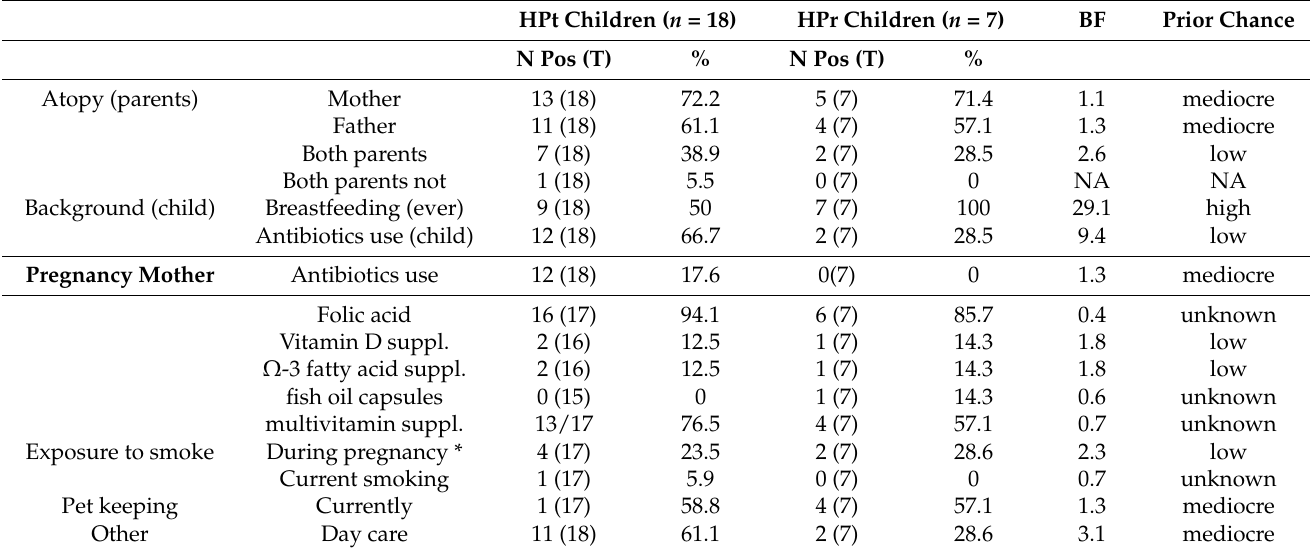
Table 4. Characteristics of the parents, households and the background of